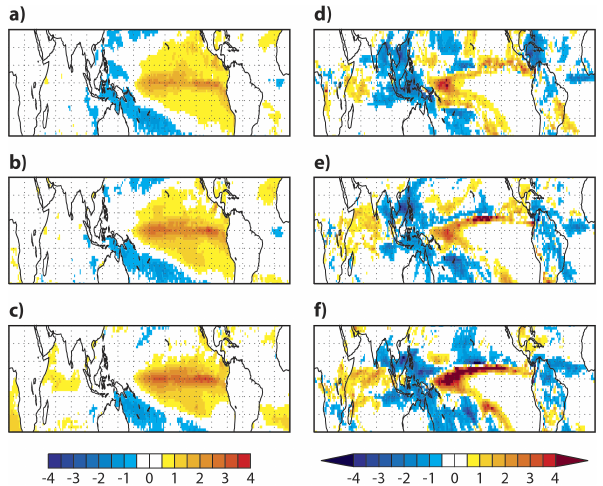
Figure 2. Left panels: anomaly of vertical velocity at 500hPa in mms − 1 calculated from the MACC reanalysis as the difference of El Niño composite minus La Niña composite for October (a) , November (b) and December (c) . Blue colours show increased as- cent, red colours increased descent. Right panels: specific humidity anomaly at 500hPa in percent calculated from the MACC reanaly- sis as the difference of El Niño composite minus La Niña composite for October (d) , November (e) and December (f) . Blue colours show reduced specific humidity, red colours increased values.